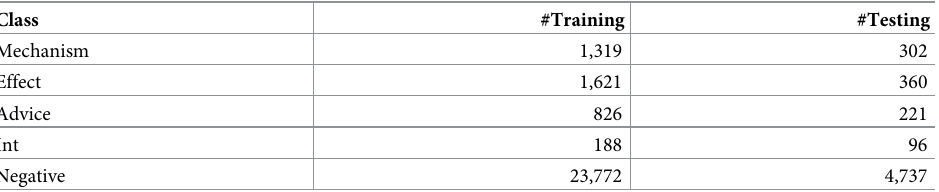
Table 5. Statistics of the DDI extraction datasets. Mechanism, Effect, Advice, Int are four types of DDIs. Negative means that the instance does not contain a DDI.